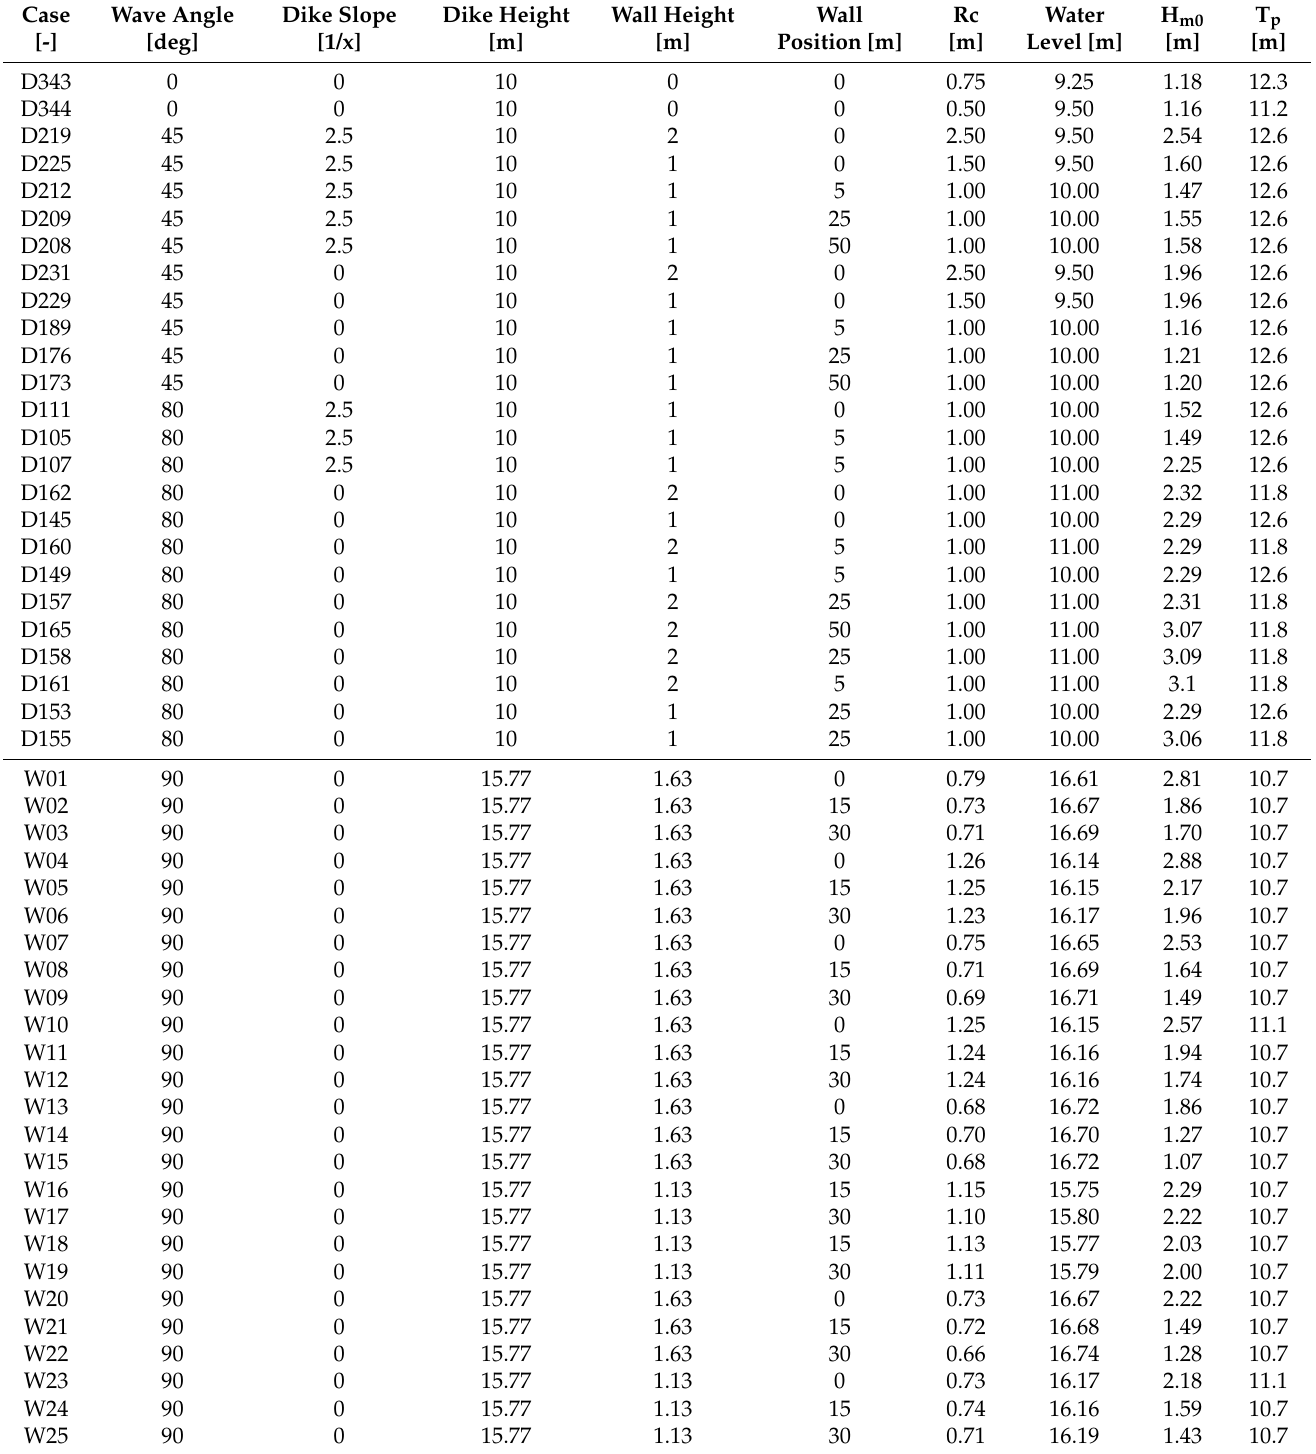
Table 1. Data for the validation cases (prototype scale). Case names starting with D are from Dan et al., and those starting with W are from Willems et